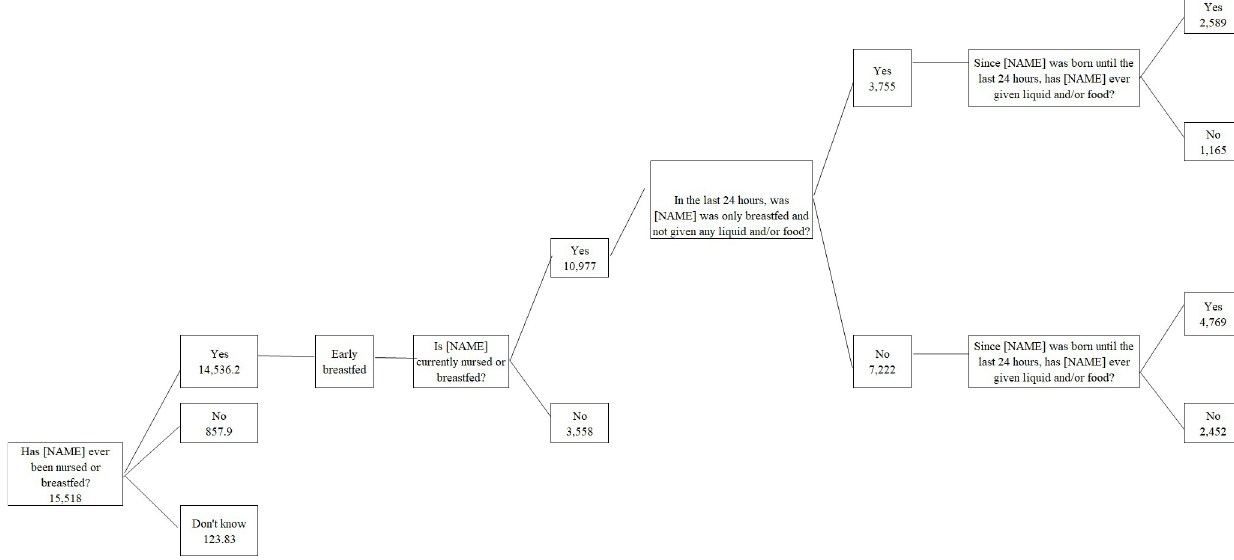
(SUSENAS) data (household respondents in RISKESDAS 2018 were the same as household